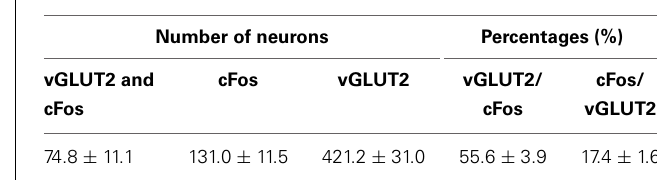
Table 2 | Numbers and percentages of vGLUT2 mRNA-positive and cFos immunoreactive neurons in the lateral PAG in female rats after mating stimulus.